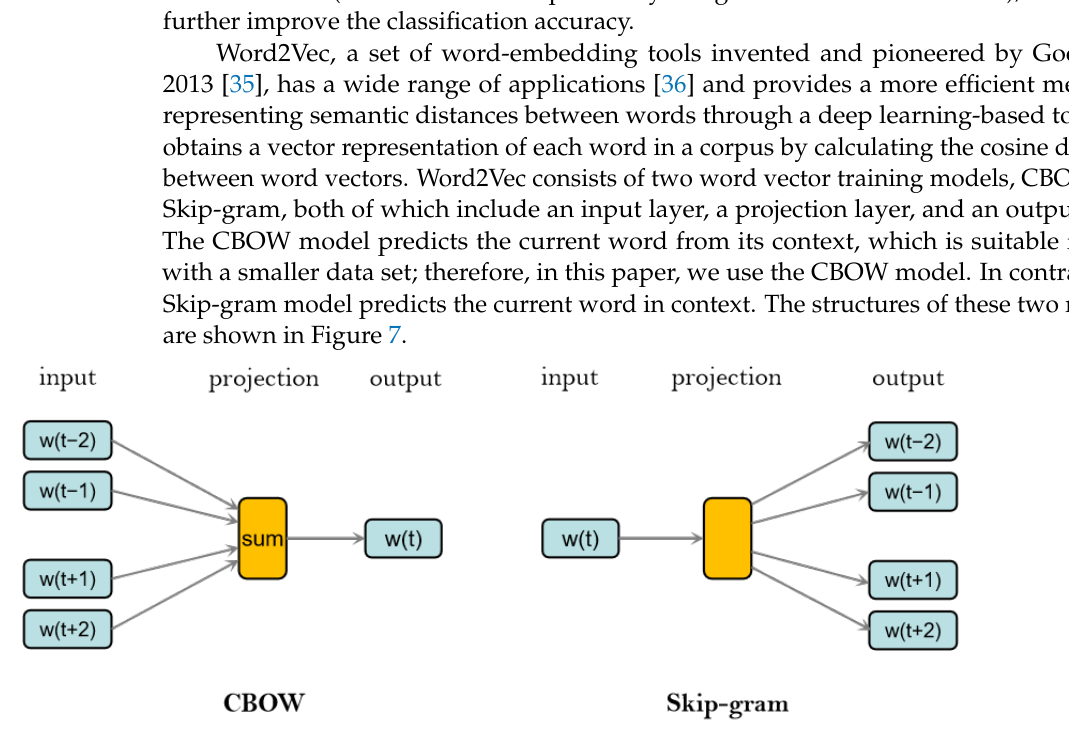
Figure 7. CBOW and Skip-gram structure diagrams.